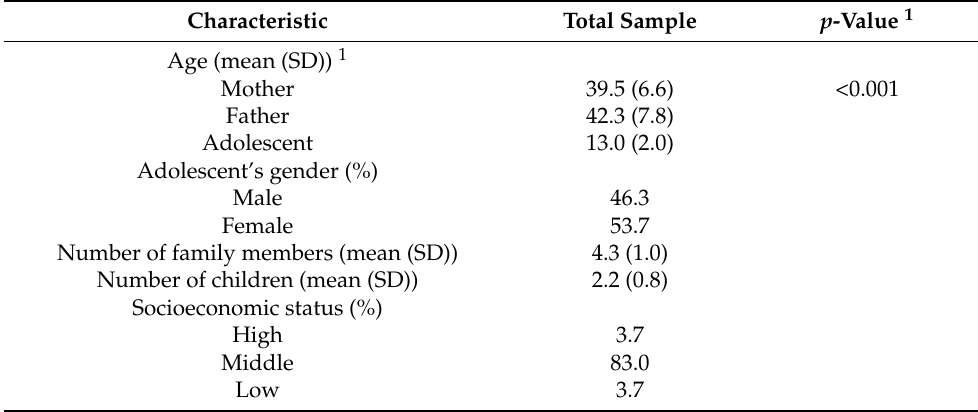
Table 1. Sample characteristics ( n =